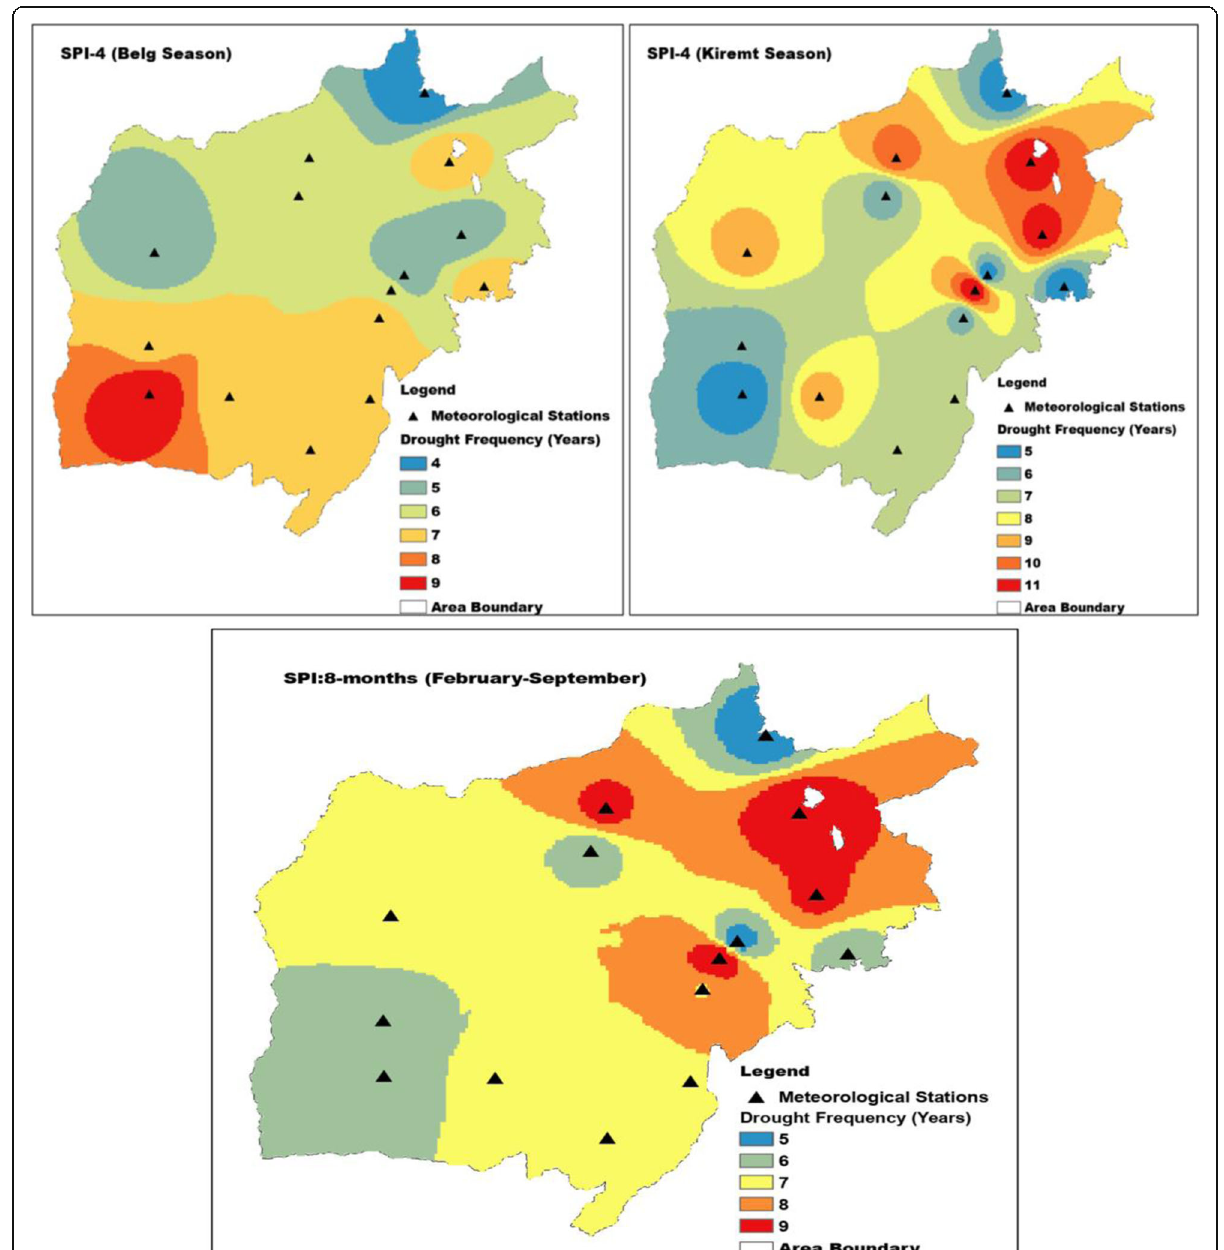
Fig. 7 The spatial pattern of drought frequency events (SPI ≤ − 1.0) for SPI: 4- month (Feb-to-May, belg ); SPI: 4- month (June-to-Sept, kiremt ); and SPI: 8-month (Feb-to-Sept)